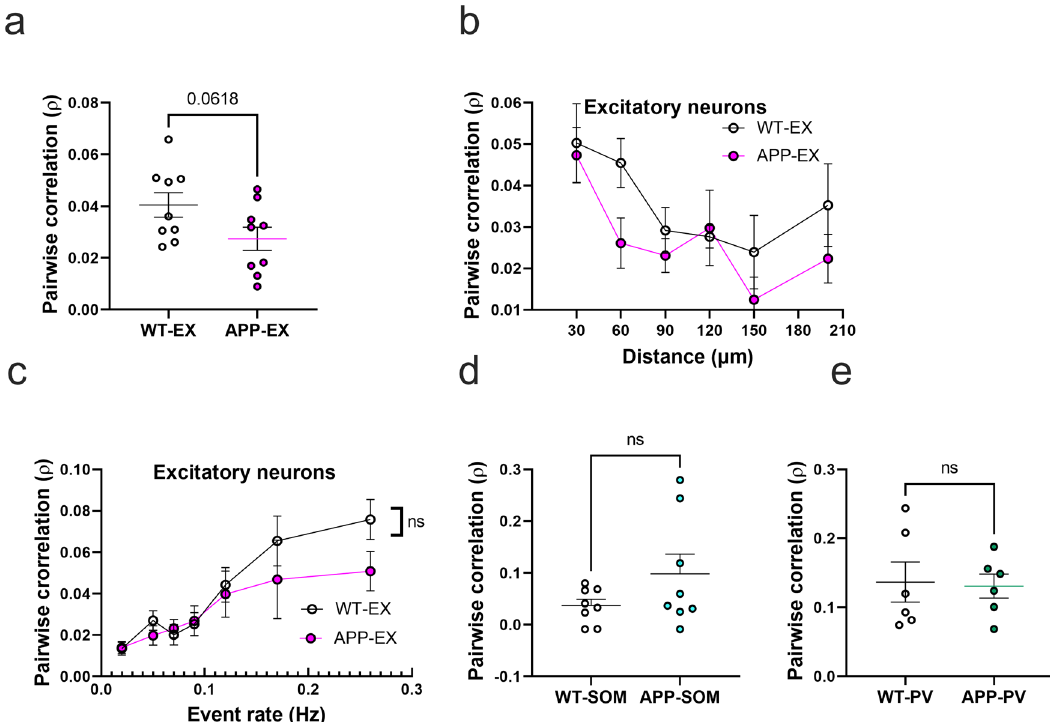
Fig. 4 Pairwise neuronal correlations in APP/PS1 mice. a Average pairwise Pearson correlation values for excitatory neurons in APP/PS1 and WT mice ( t (16) = 2.008, n = 9WT-EX mice, n = 9 APP-EX mice, p < 0.062, two-tailed). b Relationship between pooled pairwise Pearson correlation values and pairwise interneuronal distance (Two-Way ANOVA, main distance effect F (5, 87) = 4.5, p = <0.001, main genotype effect F (1, 87) = 4.38, p = 0.039, main genotype and distance interaction F (5, 87) = 0.62, p = 0.682). The x axis values represent the maximum limit of the pooled pairwise distances. c Relationship between correlation values and event rates after pooling data according to geometric means of neuronal event rates (two-way ANOVA, main event rate effect F (6,107) = 9.7, p < 0.0001, main genotype effect F (1, 107) = 24, p = 0.1223, main genotype and event rate interaction F (6, 107) = 0.7, = 1.54, n = 8 WT-SOM mice, n = 8 APP-SOM mice, p = 0.147, p = 0.58). d , e Average pairwise Pearson correlation values for SOM interneurons ( d ) ( t (14) two-tailed) and PV interneurons ( e ) ( t (10) = 0.16, n = 6 WT-PV mice, n = 6 APP-PV mice, p = 0.95, two-tailed) in APP/PS1 and WT mice. All error bars re fl ect the mean ±